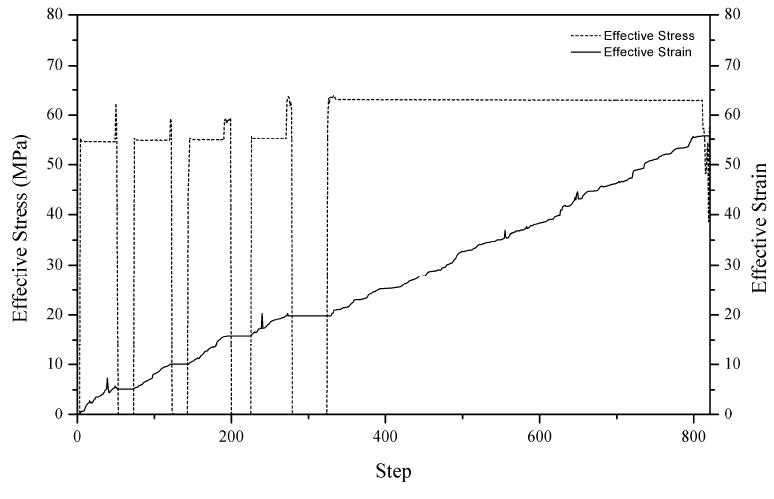
Figure 6. Effective stress–strain recorded for the HPF process at each simulation step.